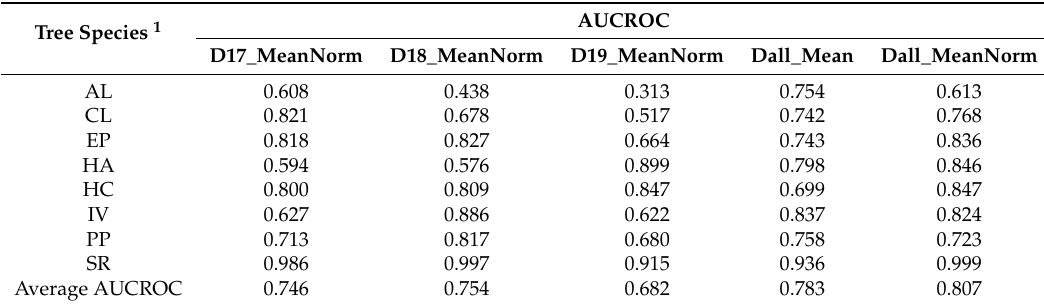
Table 6. AUCROC values for each tree species identified in each dataset. AUCROC values are from imagery data of (i) only 2017 (D17_MeanNorm); (ii) only 2018 (D18_MeanNorm); (iii) only 2019 (D19_MeanNorm); (iv) all years and the mean spectral values (Dall_Mean); and (v) all years and the mean normalized values